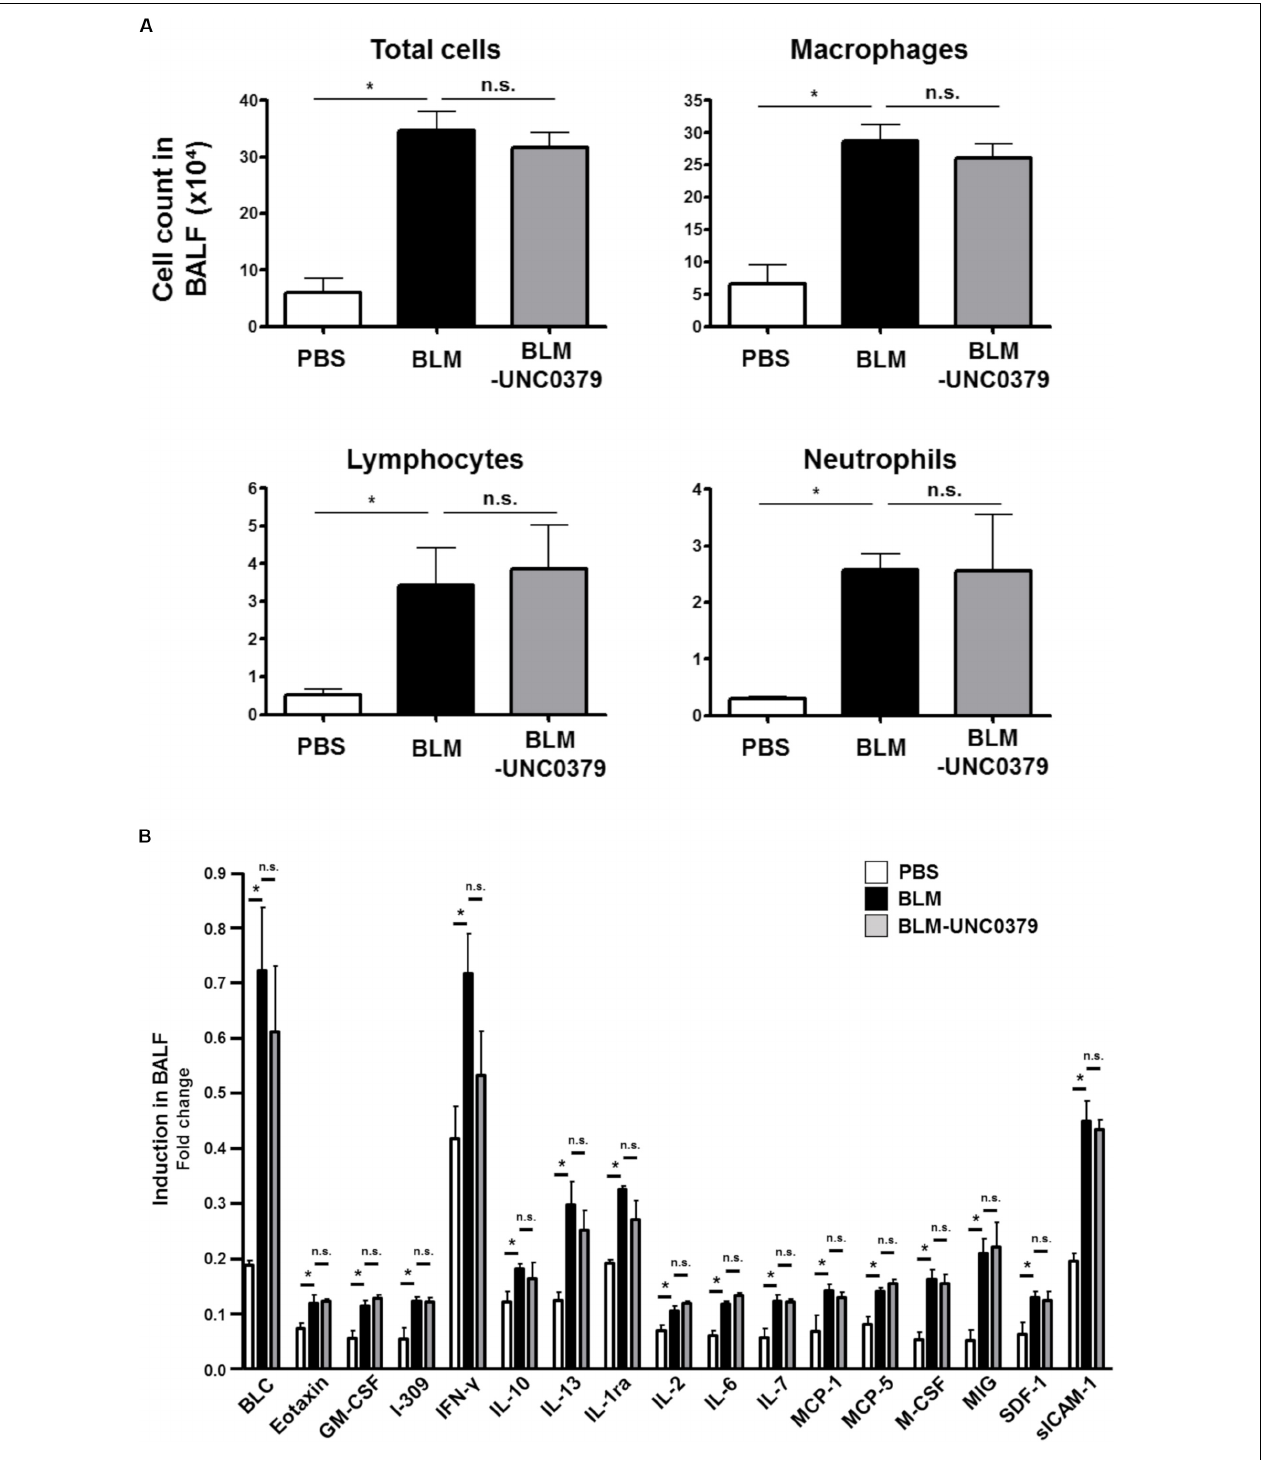
FIGURE 3 | UNC0379 does not affect the inflammatory cells, but the cytokine production increased in the BAL fluids of mice instilled with BLM. (A) The number of total cells, macrophages, lymphocytes, and neutrophils in the BAL fluids at 10 dpi were compared between the PBS, BLM, and BLM-UNC0379 groups. Data are shown as the mean ± SEM ( n = 4). * p < 0.05, n.s., no significant difference (measured by one-way ANOVA followed by Tukey’s test). (B) The expression profile of inflammatory cytokines in the BAL fluids at 10 dpi was analyzed by cytokine array and densitometric quantification. Each signal represents the mean fold-change ± SEM compared to the positive internal standard in the array membrane ( n = 4). * p < 0.05, n.s., no significant difference (measured by one-way ANOVA followed by Tukey’s